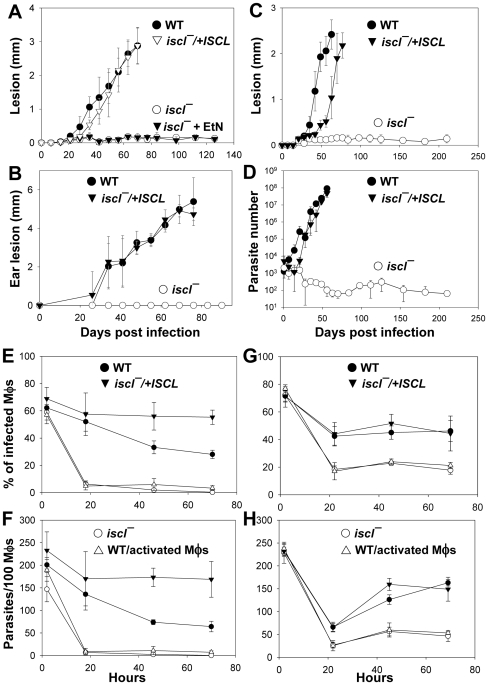

ISCL is essential for acute virulence but not persistence.(A)–(B) Iscl− mutants failed to induce pathology in mice. BALB/c mice were infected in the footpads (A) or ears (B) with stationary phase promastigotes and lesion sizes were measured weekly with a caliper. (C)–(D) Iscl− mutants were able to persist at low levels. BALB/c mice were infected in the footpads with purified metacyclics at 2×105 parasites per mouse. Lesion sizes were measured with a caliper (C) and parasite numbers in infected footpads were determined by the limiting dilution assays (D). (E)–(H) Iscl− infection of peritoneal macrophages (Mφs). Stationary phase promastigotes were used to infect peritoneal Mφs from BALB/c mice as described [38]. Percentages of infected Mφs (E, G) and the number of parasites per 100 Mφs were recorded (F, H). Experiments were performed at 37 °C (E, F) or 33 °C (G, H). As a control, WT parasites were also used to infect activated Mφs (▵: stimulated with 100 ng/ml of LPS and 100 ng/ml of IFN-γ) to ensure these Mφs possessed microbicidal activities. Error bars represent standard deviations.